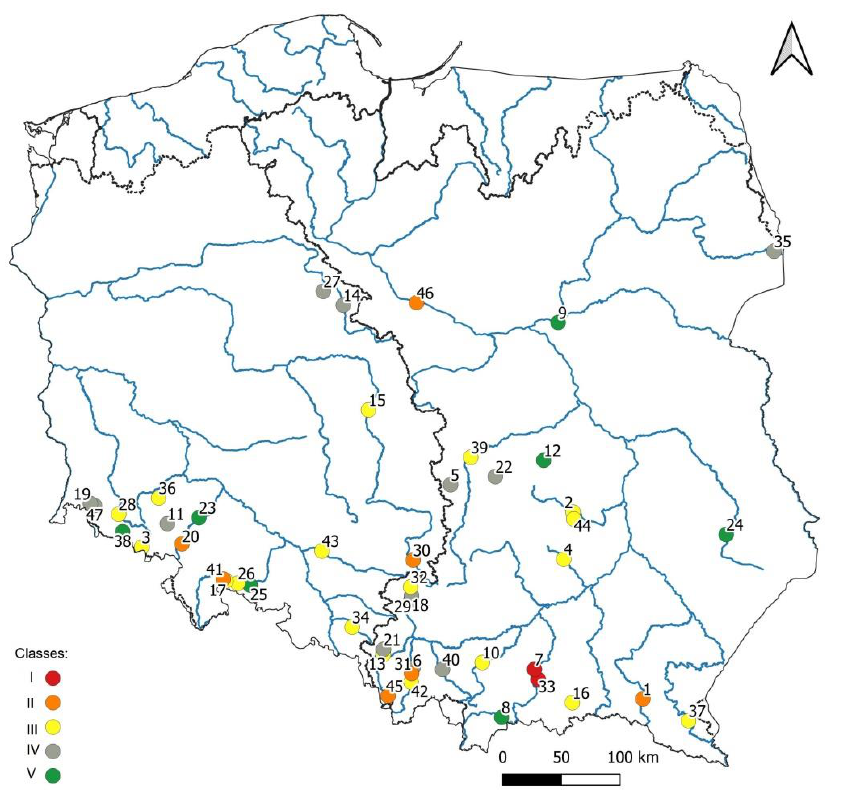
Figure 3. Structure of capacity change in reservoirs of key importance for water management in Poland. Classes: I — large loss of capacity — over 30% (red), II — significant loss of capacity — 10.1 – 30% (orange), III — moderate loss of capacity — 0.1 – 10% (yellow), IV — constant unchanged capacity (no color), V — increase in capacity (green).